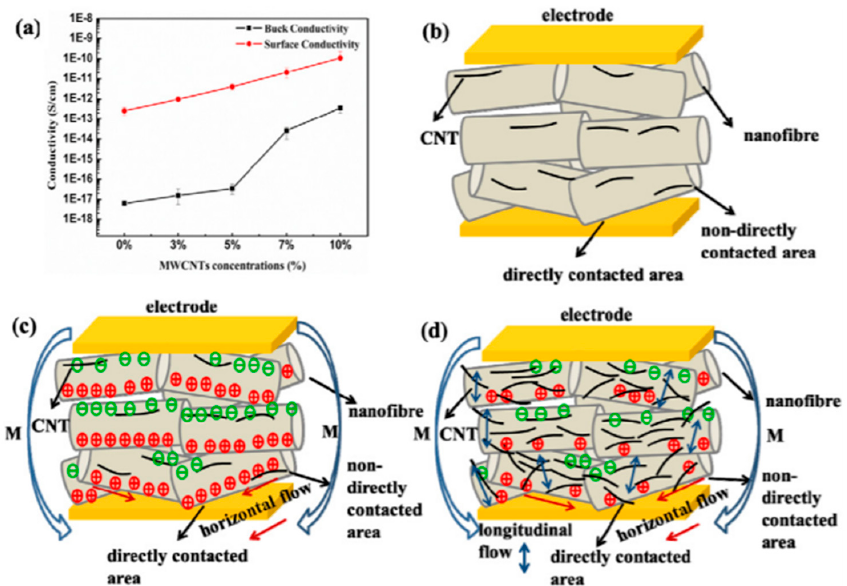
Figure 14. ( a ) The volume and surface conductivities of polyvinylidene fluoride (PVDF) / multiwalled- carbon nanotubes (MWCNTs) nanofiber mats for different concentrations of MWCNTs dosages; ( b ) schematic diagram of PVDF / MWCNTs nanogenerator without stress; ( c ) working schematic of the PVDF-3% CNTs and PVDF-5% CNTs nanogenerators under stress; ( d ) working schematic of the PVDF-7% CNTs and PVDF-10% CNTs nanogenerators under stress. Reprinted with permission from [119].